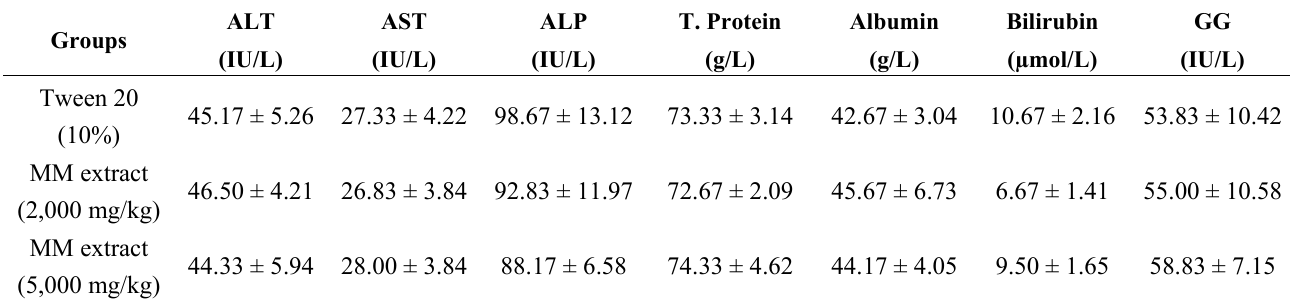
Table 4. Effects 2,000 mg/kg and 5,000 mg/kg of MM extract on liver biochemical parameters.